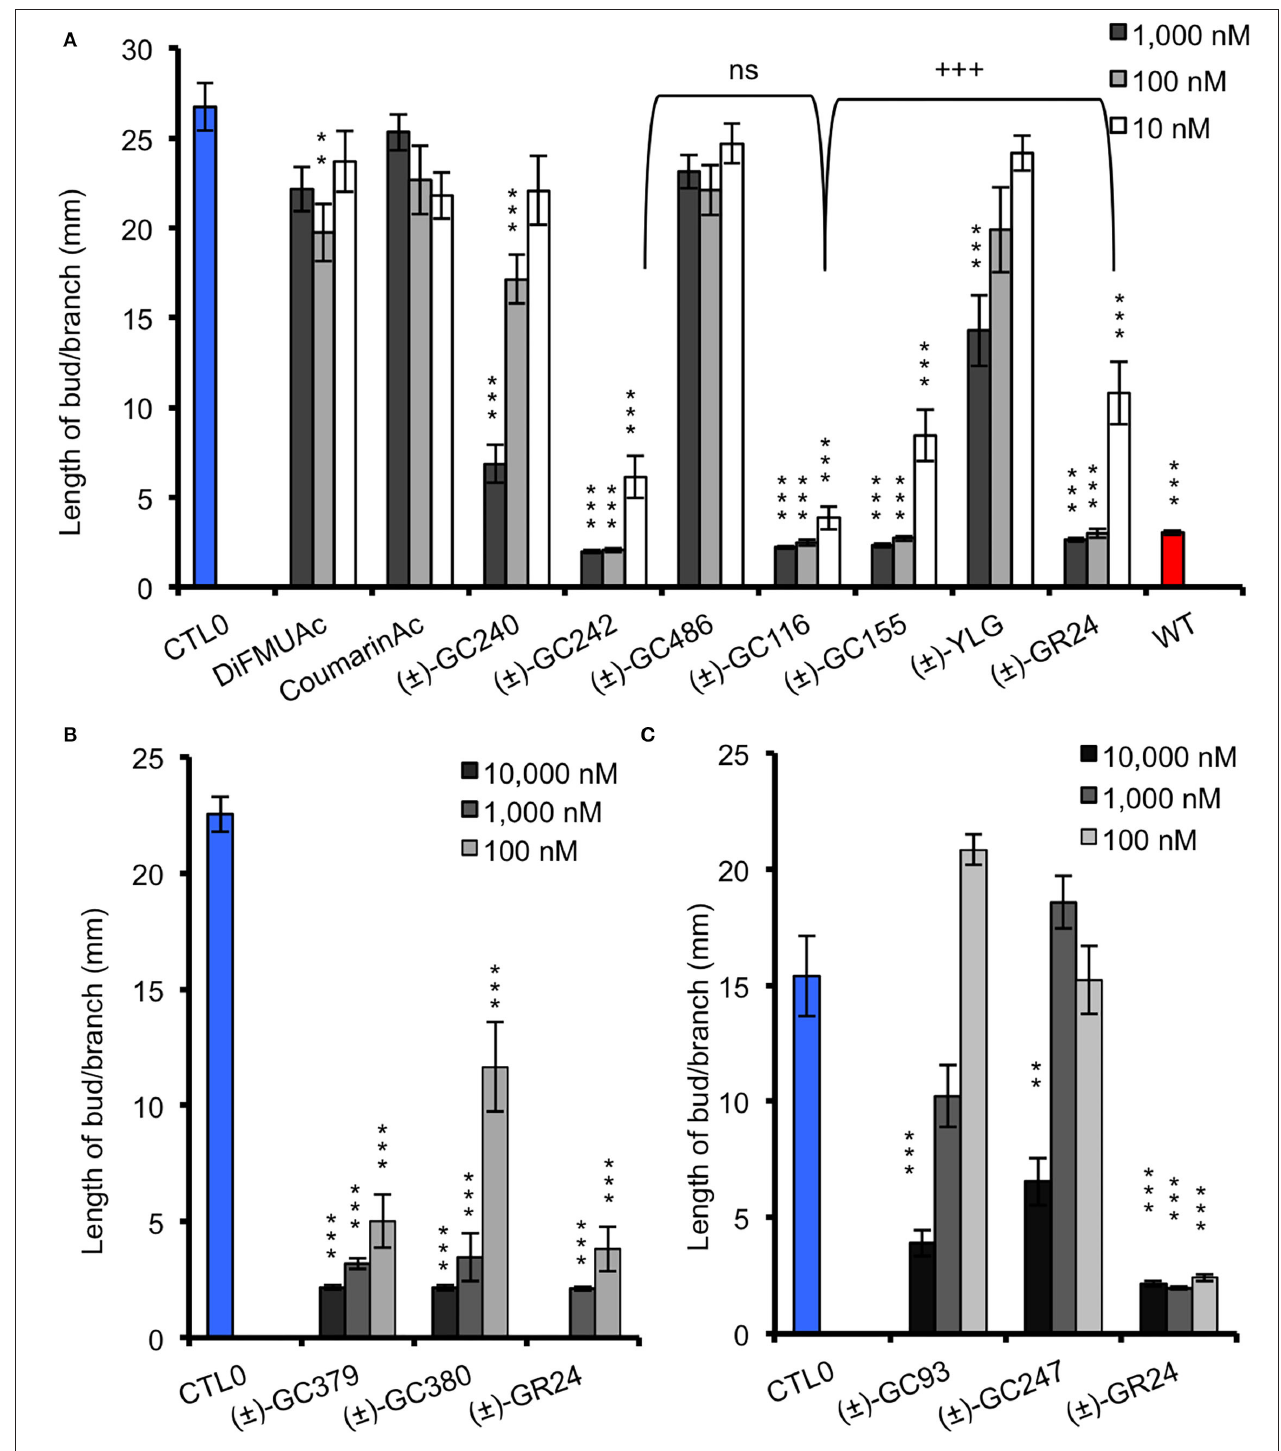
FIGURE 5 | Bioactivity in pea of probes vs. ( ± )-GR24 ( rms1-10 ), coumarin and fluorescein probes (A) , scopoletin probes (B) , and resorufin derivative probes (C) . Length of the axillary buds of rms1-10 plants, 8 days after direct application of probes and of ( ± )-GR24. All replicates are presented in Supplementary Table 1 with control 0. These data were obtained from means ± SE ( n ≥ 20 plants). ** P < 0.01, *** P < 0.001 indicate significant differences with the control treatment (0nM) (CTL0) (Kruskal–Wallis rank sum test). CTL0, control 0. All the replicates are presented in Supplementary Table 1 . +++ P < 0.001 indicates significant differences with the ( ± )-GR24 treatment (10nM) (Kruskal–Wallis rank sum test). ns, not significant.